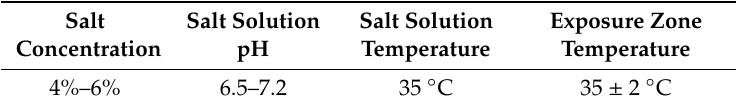
Table 2. Standard test parameters for B-117 testing.